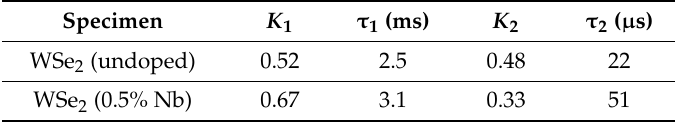
Figure 3. Normalized photoconductivity as a function of the frequency of undoped and 0.5% Nb-doped WSe 2 -layered crystals. Table 2. The obtained values of coefficients from the least-square fits to Equation (2) for undoped and 0.5% Nb-doped WSe 2 -layered